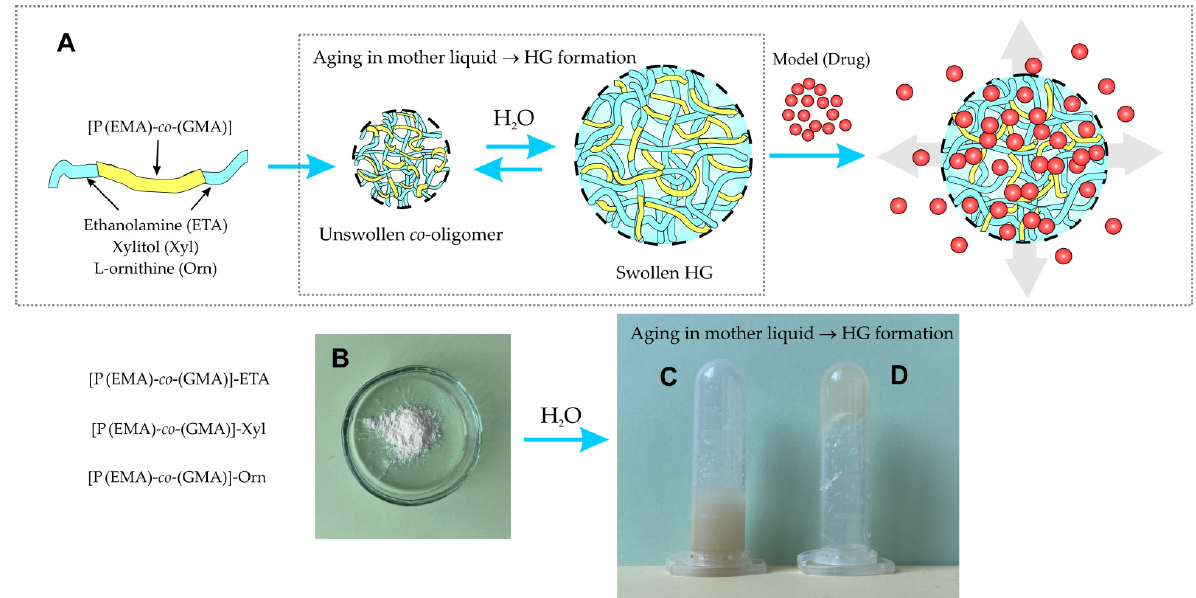
Scheme 2. ( A ) Graphical representation of HGs preparation. Photographs of ( B ) co and ( D ) co -oligomer after aging (HG).